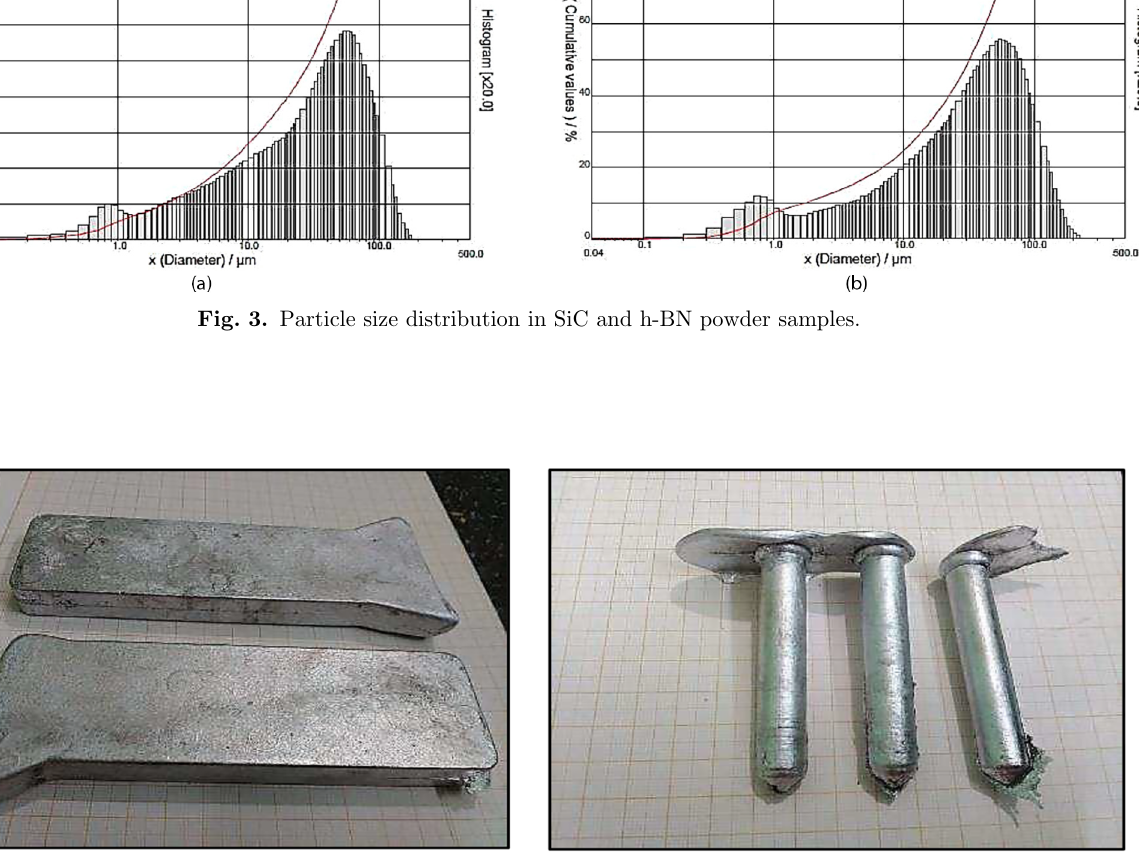
Fig. 4. Sample composite